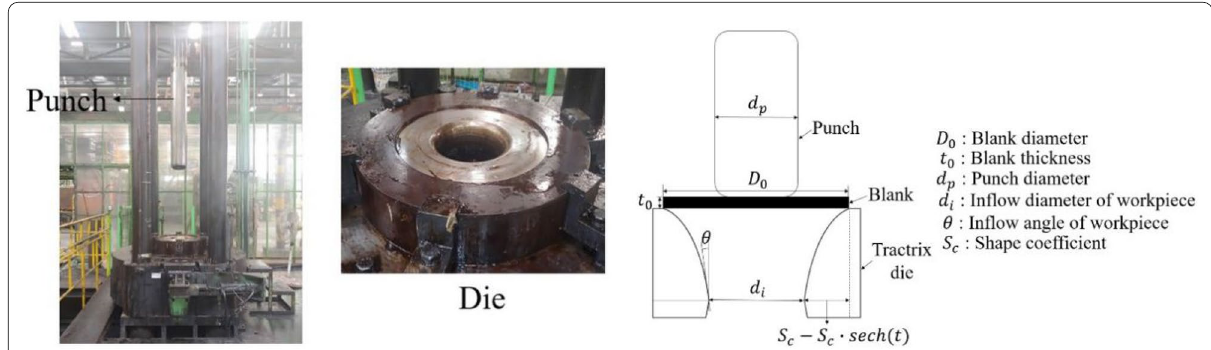
Figure 2 Scheme of 1 st deep drawing